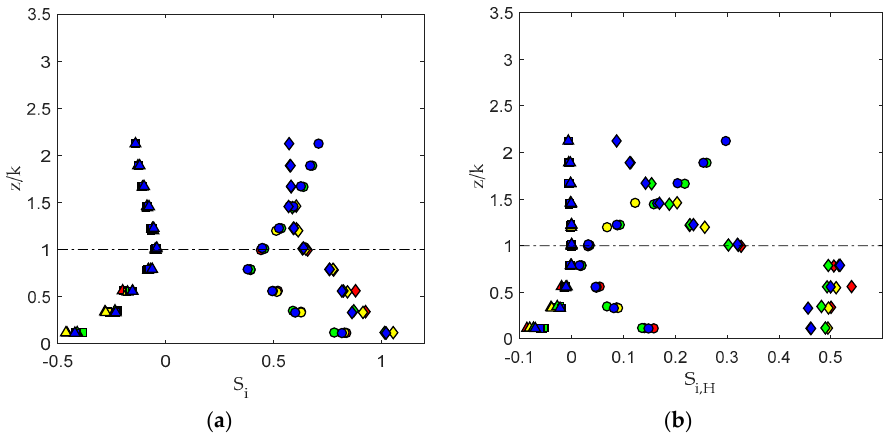
Figure 8. Contribution of each quadrant to the overall Reynolds stress: ( a ) evaluated with Equation (2) considering all the events, and ( b ) evaluated with Equation (3) considering only the extreme events, assuming the H parameter equal to 2. Inward S 1 and outward S 3 interactions are represented by solid squares ( ■ ) and triangles ( ▲ ), respectively, and sweep S 2 and ejection S 4 interactions by diamonds ( ♦ ) and circles ( ● ). The different colors refer to the four different considered conditions: blue: 30 L/s; green: 25 L/s; yellow: 20 L/s; red: 15 L/s.